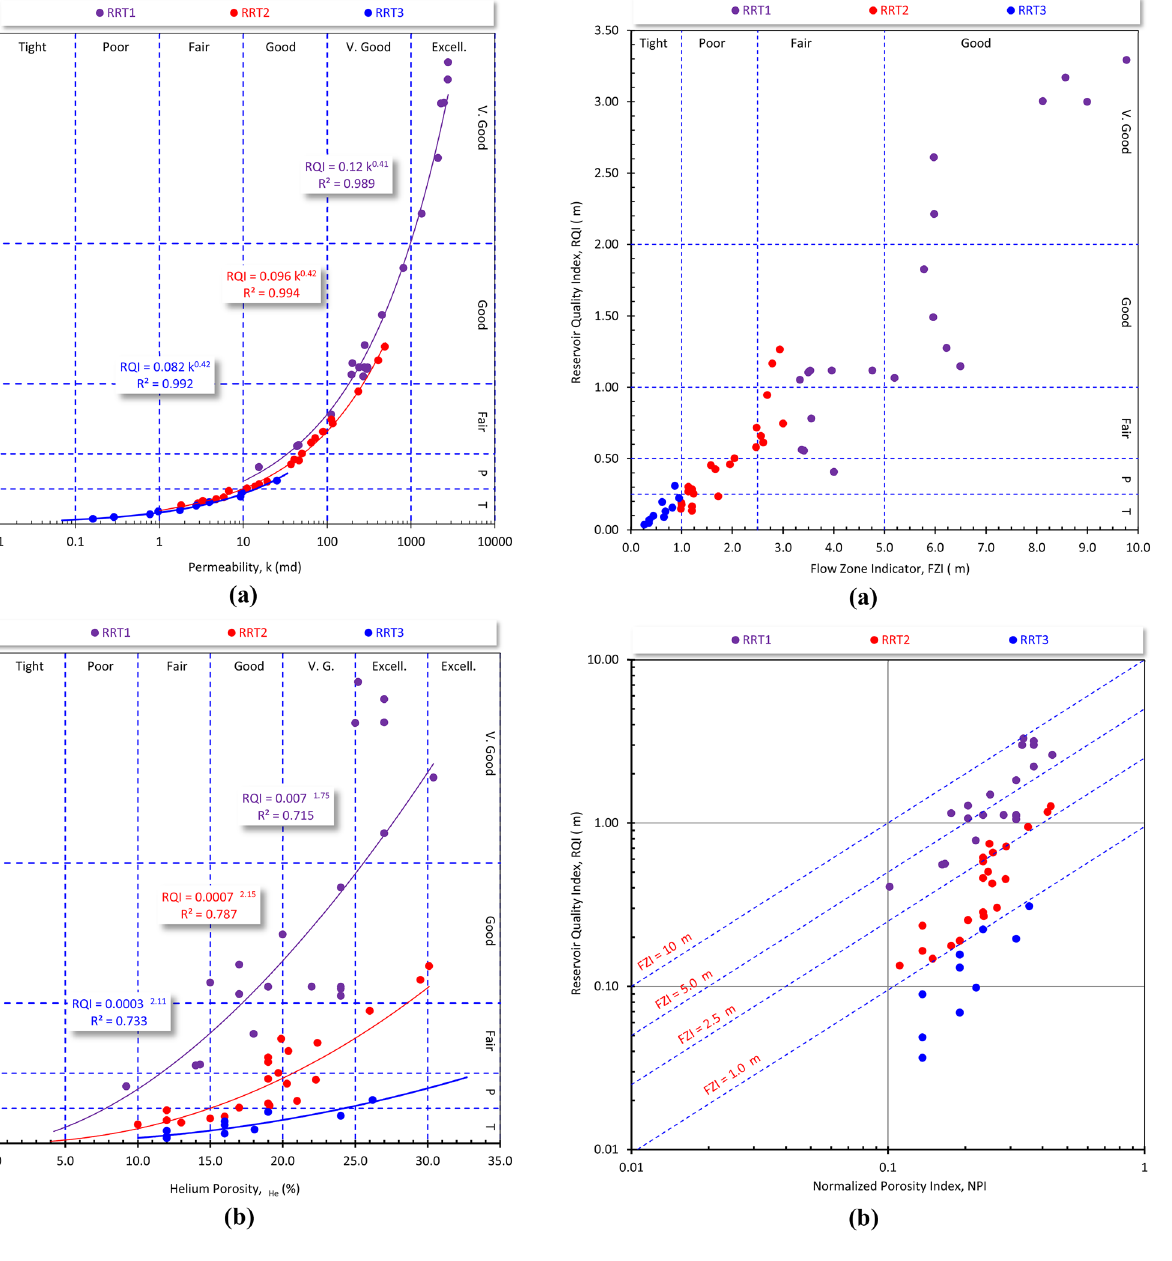
Fig. 18 Presenting the reservoir quality index (RQI) versus a the flow zone indicator (FZI), and b the normalized porosity index (NPI) superimposed by the FZI values of the Albian sequence. P and T refer to poor and tight qualities,